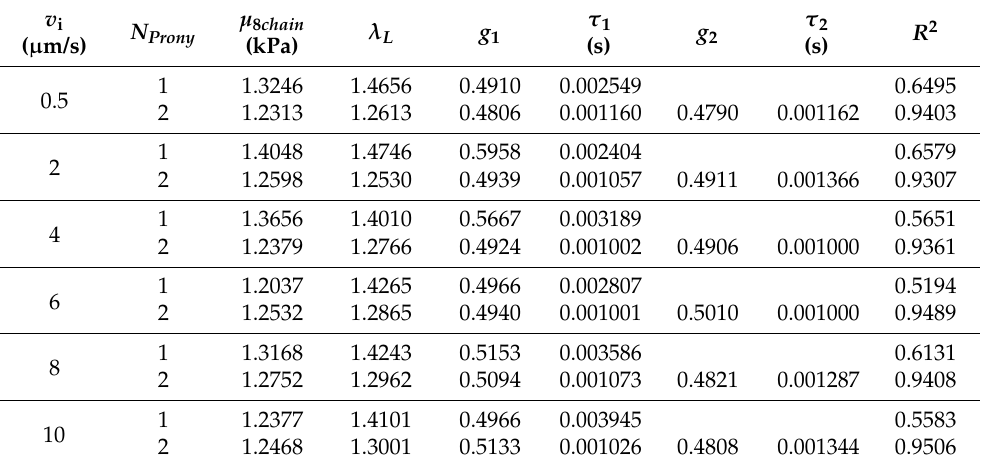
Table 1. Results of immature equine ZP identification process for the Arruda–Boyce